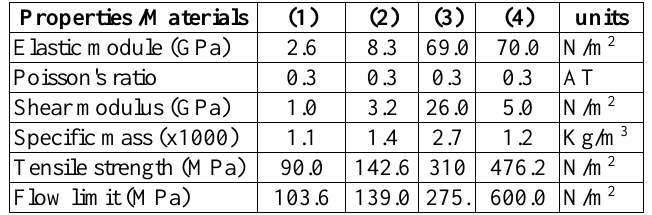
Table 7: Materials and properties landing gear.